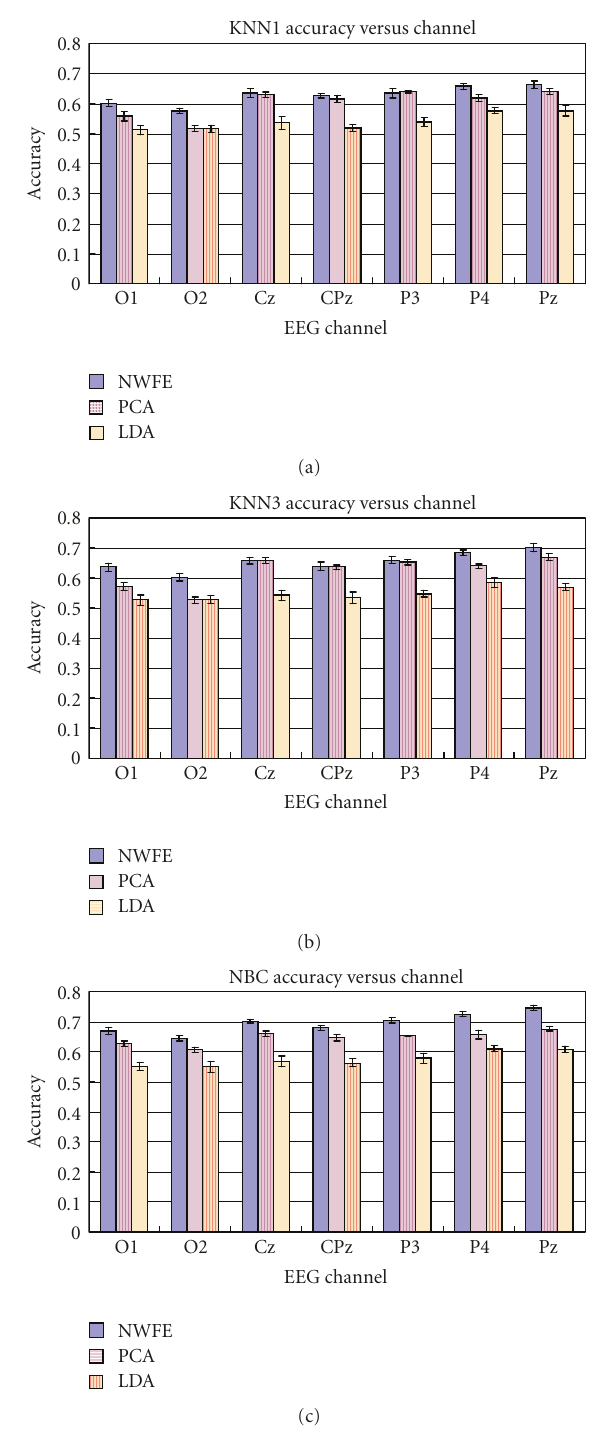
Figure 3: Accuracy plot for di ff erent EEG channels. response, channels such as O1, O2, Cz, CPz, P3, P4, and Pz were tested. The average accuracy and standard deviation using KNN1, KNN3, and NBC classifiers were plotted in Figure 3 using the optimal feature number most suitable for each channel. From the data in Figure 3 for the KNN1 classifier, it can be seen that data from the Pz